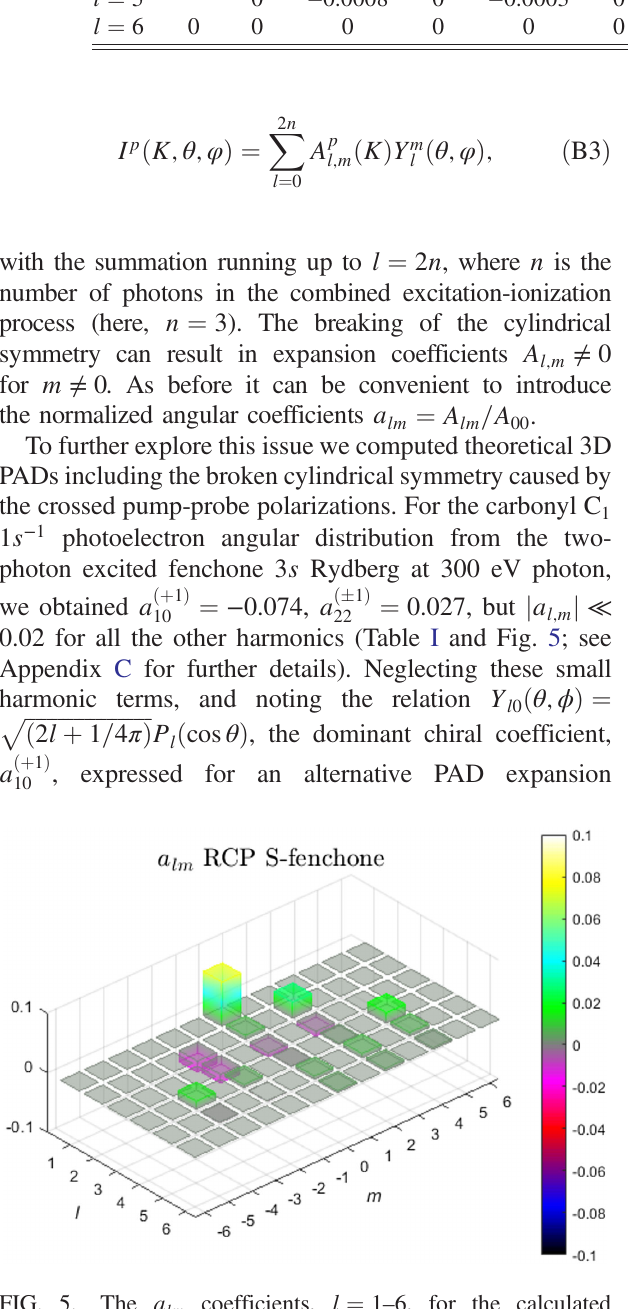
FIG. 5. The a coefficients, l ¼ 1 – 6 , for the calculated lm S-(+)-fenchone C 1 1 s − 1 PAD. See Table I and note that this figure is for right circular polarization ( p ¼ −